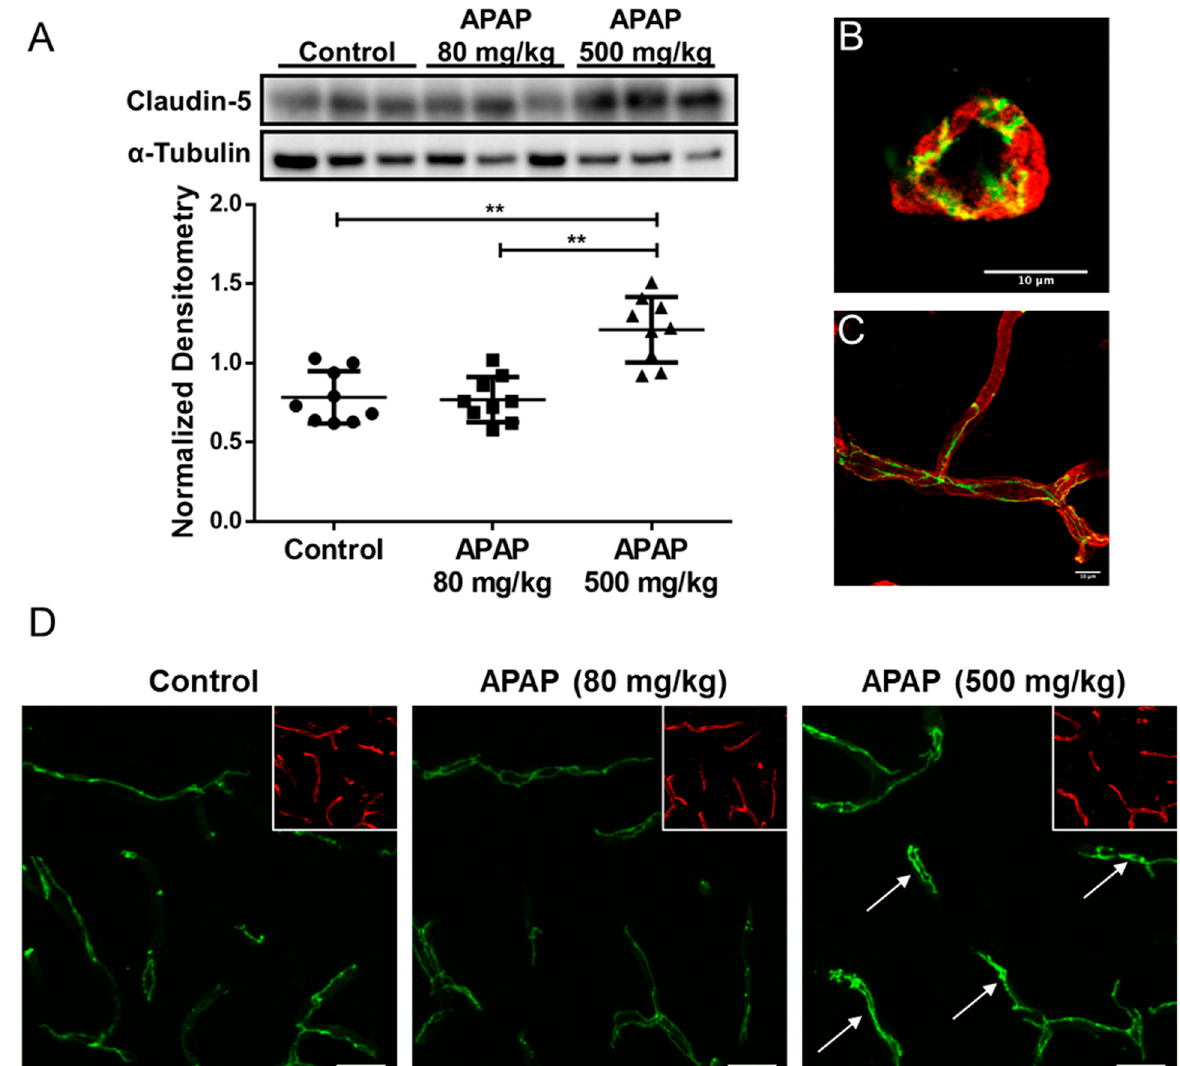
Figure 2. Claudin-5 level increases in BBB microvessel endothelial cells three hours after high-dose APAP treatment. ( A ) Western blot ( top ) and densitometric analysis ( bottom ) of claudin-5 levels in isolated brain microvessel of rats ( n = 9) treated with low-dose APAP (80 mg/kg) and high-dose APAP (500 mg/kg) shows statistical significance between the three groups ( p = 0.000012), as well as between vehicle and the high-dose groups ( p = 0.00018; Student’s t -test) and between low-dose and high-dose groups ( p = 0.000074). No statistical significance was detected between the vehicle and the low-dose APAP group ( p = 0.84). Densitometric data are expressed as mean ± S.D. (** p < 0.0001). High magnification confocal microscopy images of a cross-section ( B ) and a longitudinal section ( C ) of a cortical microvessel showing claudin-5 localization (green) within the microvessel labeled with the vascular marker tomato lectin (red). ( D ) confocal microscopy images indicate higher overall claudin-5 expression in cortical microvessel of rats treated with high-dose APAP (500 mg/kg) than vehicle, but not in those treated with low-dose APAP (80 mg/kg). Arrows show sites of claudin-5 upregulation. Microvessels were stained with lectin (red) and are shown in the inset to demonstrate vascular localization of claudin-5. Scale bar = 20 µ